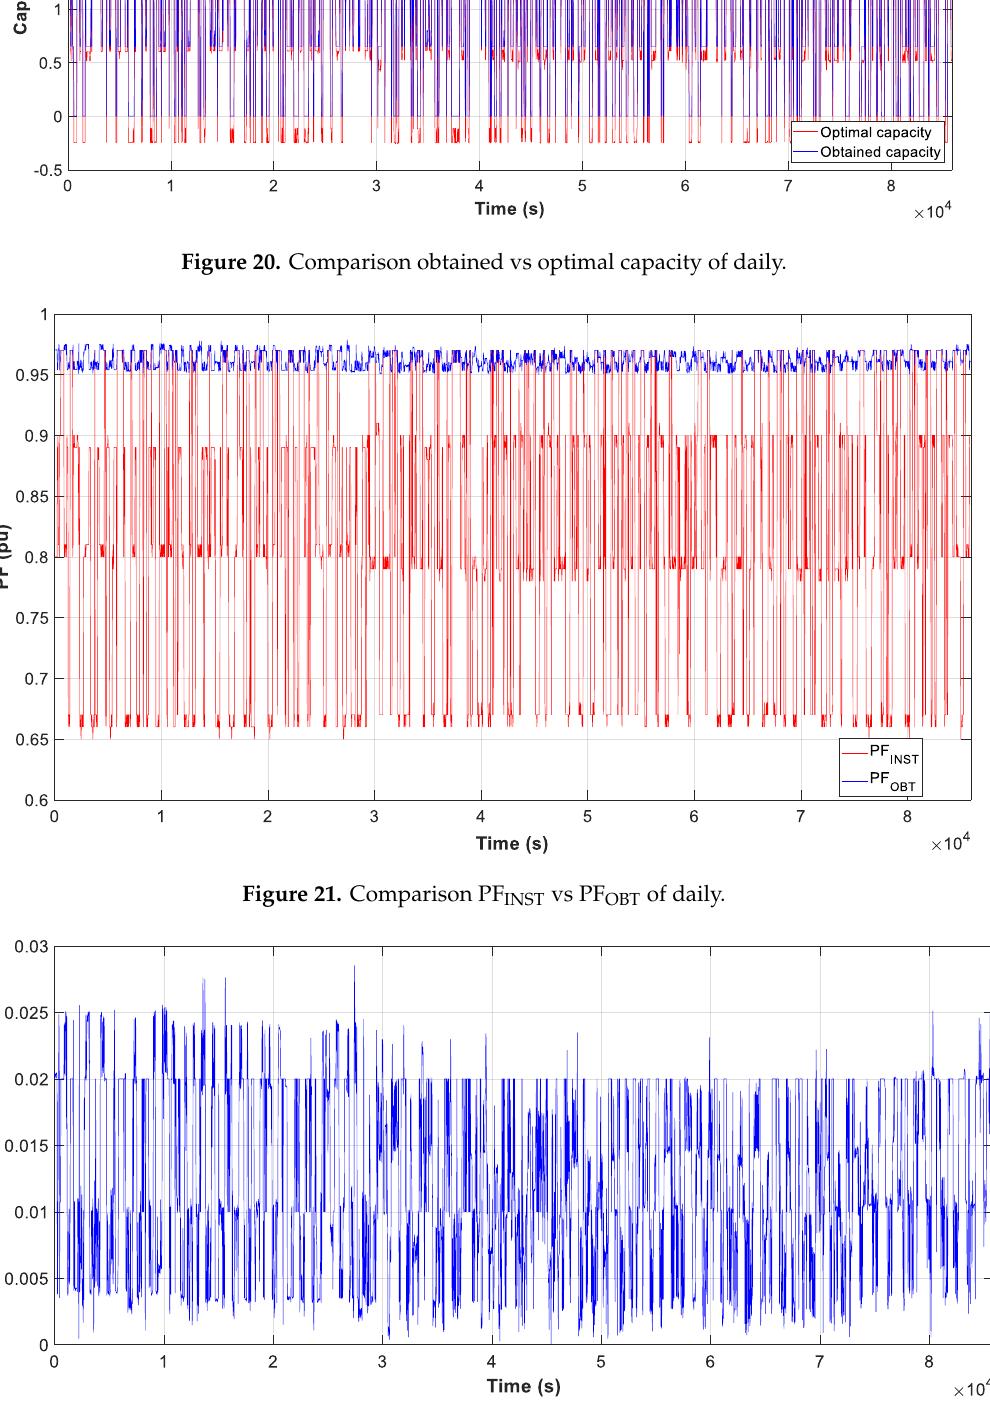
OBT and PF DES of